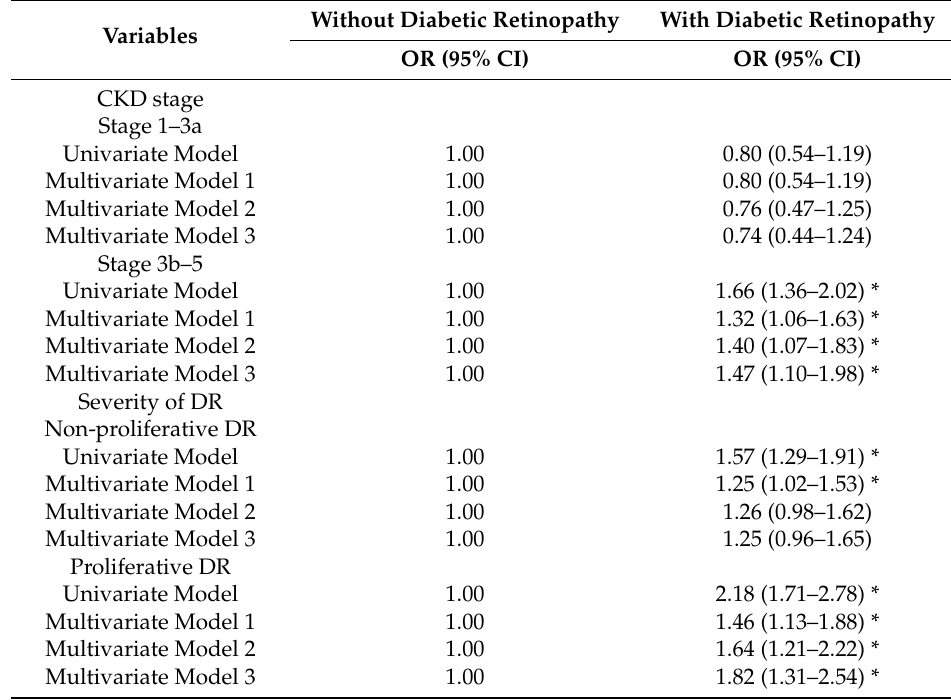
Table 3. The association between diabetic retinopathy and risk of CKD progression by CKD stage and severity of diabetic